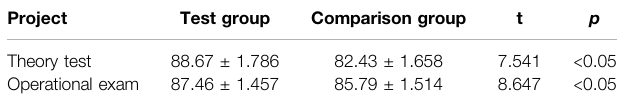
TABLE 7 | Comparison of experimental results. Project